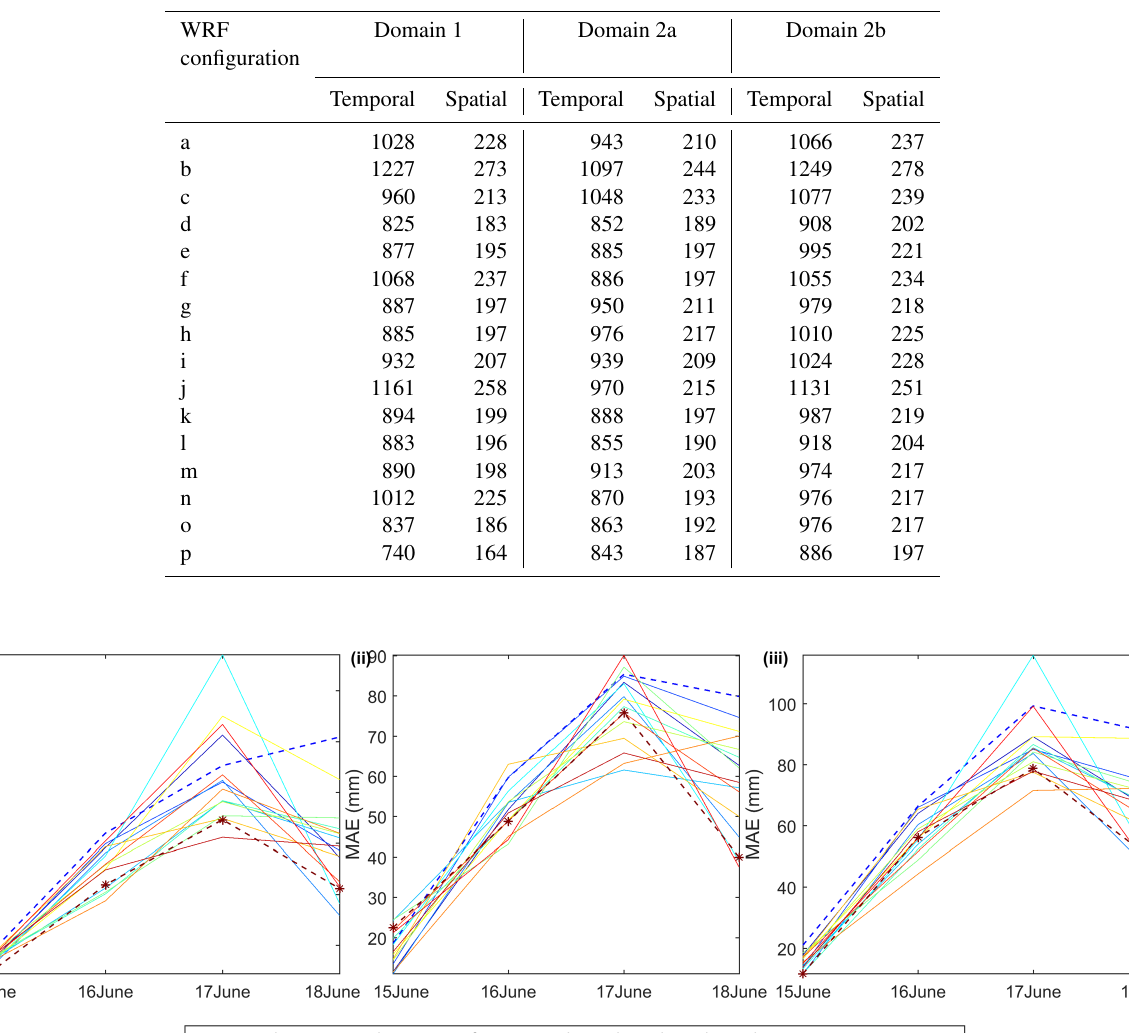
Table B1. Mean absolute error (MAE) values corresponding to different WRF configuration for the three domains.